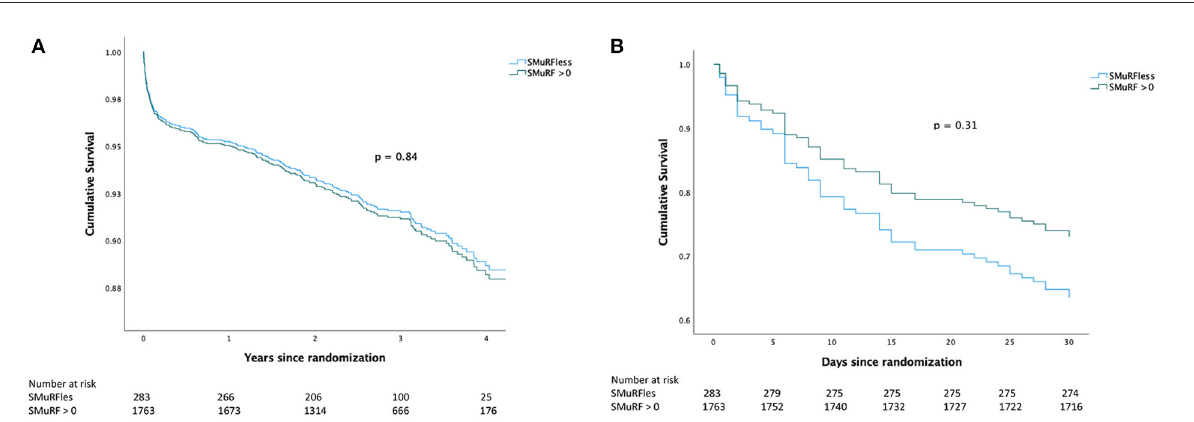
FIGURE3 Kaplan-Meier curves. (A) Shows the Kaplan–Meier curve for the long-term composite endpoint of all-cause mortality and hospitalization for heart failure. (B) Shows the Kaplan–Meier curve for the composite endpoint of all-cause mortality and hospitalization for heart failure at 30 days.